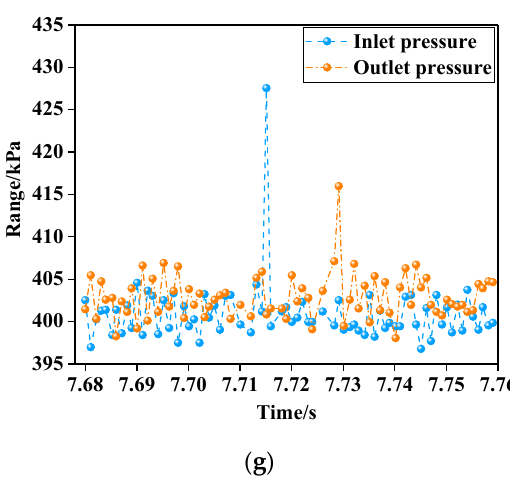
Figure 7. Experimental pressure detection chart ( a , b , c , d , e , f and g show the pressures of air ( a ) and gas concentrations of 1.00%, 1.10%, 1.20%, 1.30%, 1.40% and 1.50%).